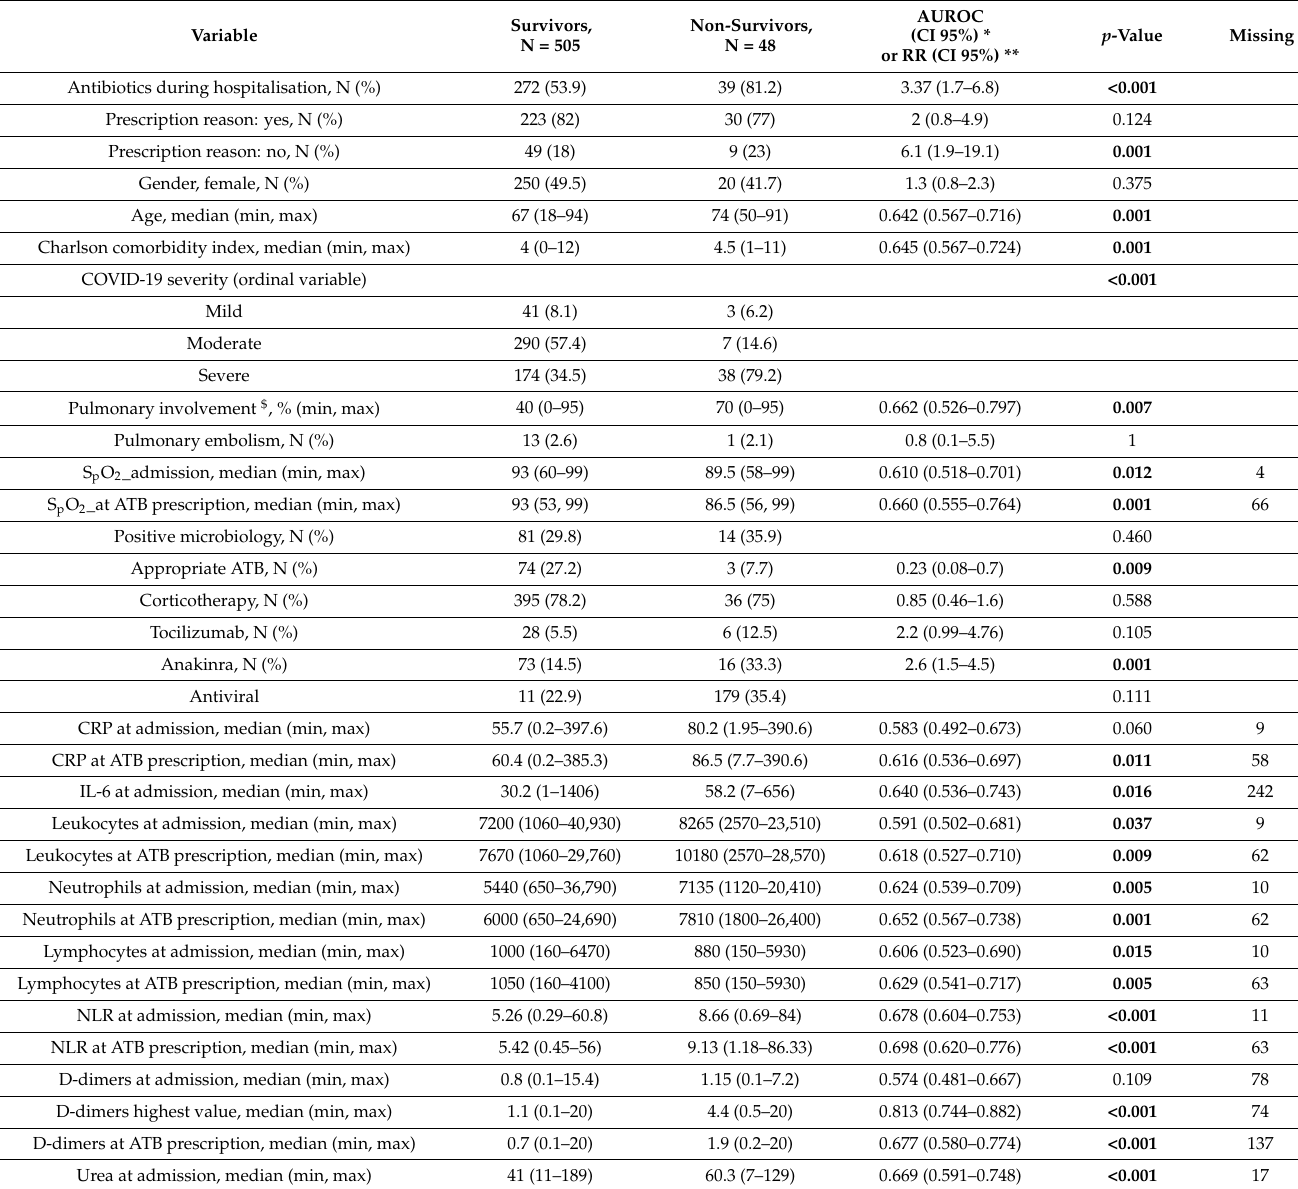
Table 3. The distribution of the variables in the survivors vs. non-survivors